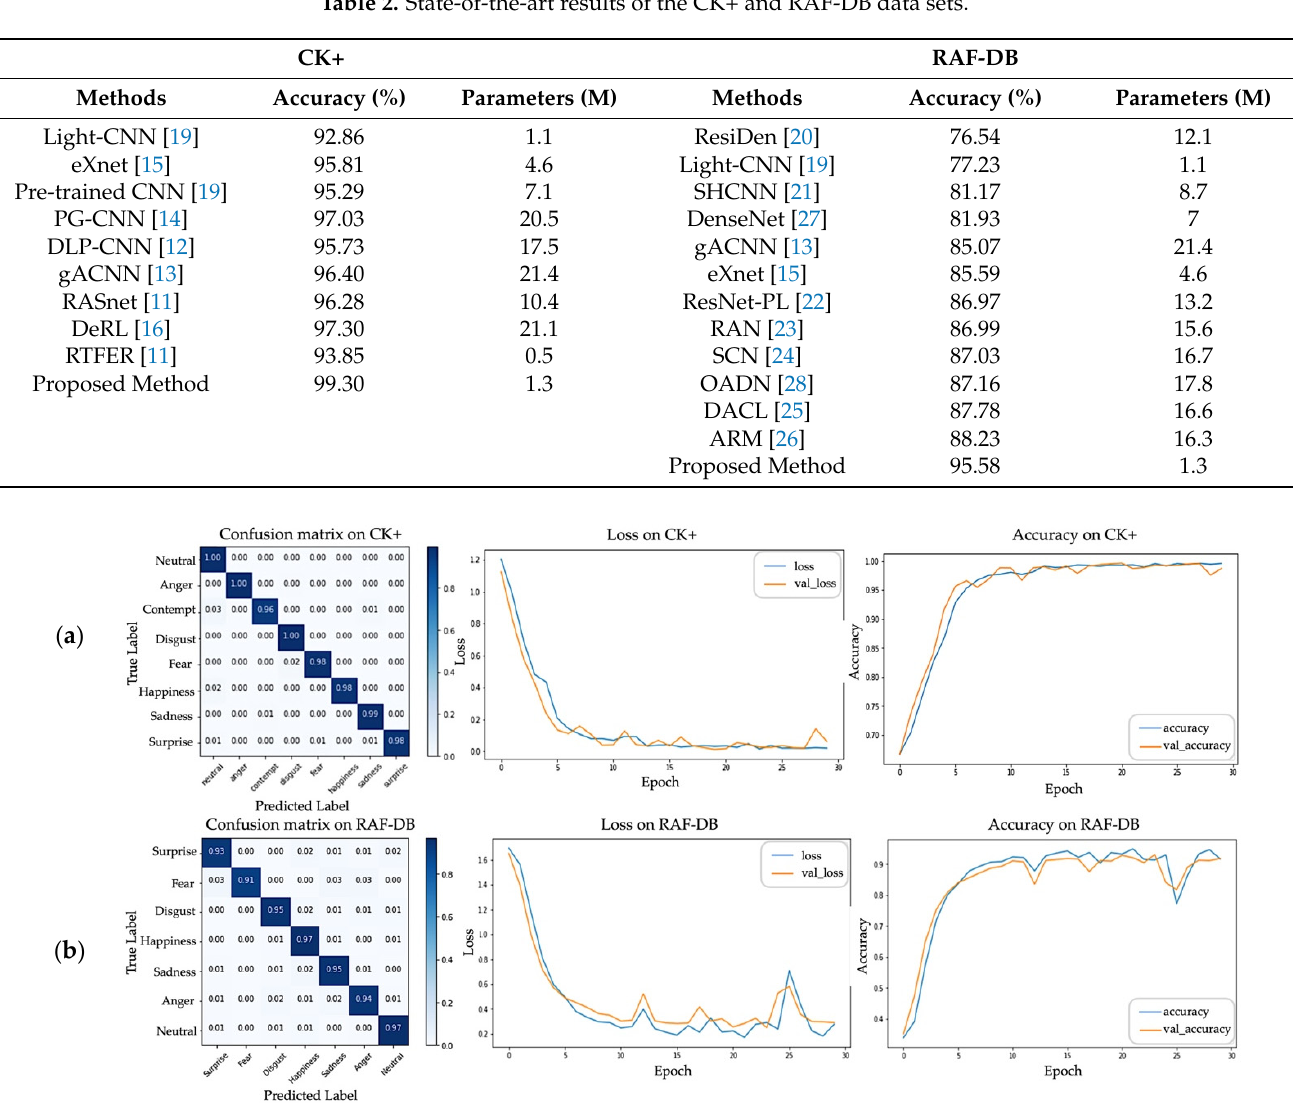
Figure 13. Results of our proposed method, including the confusion matrix as well as the loss and accuracy graphs; ( a ) results for CK+; ( b ) results for